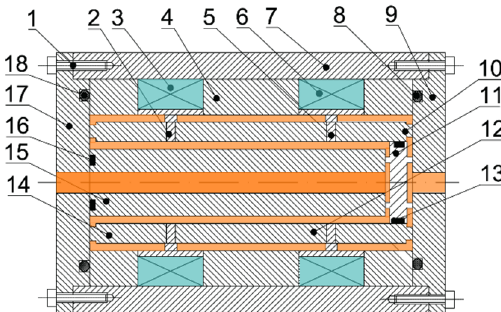
Figure 1. Structure of annular multi-channel MR valve.